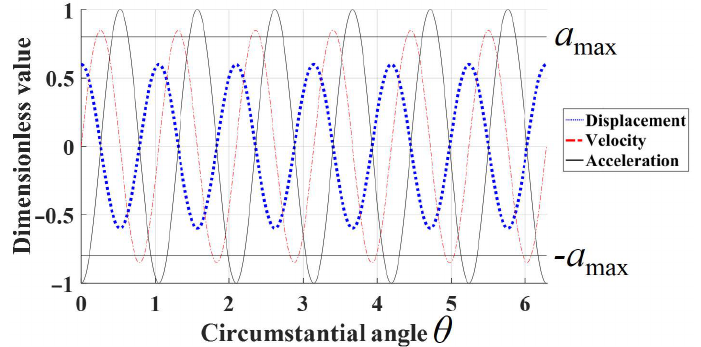
Figure 4. Schema of motion of structure with 6 ND at t = 0. Stick − Slip